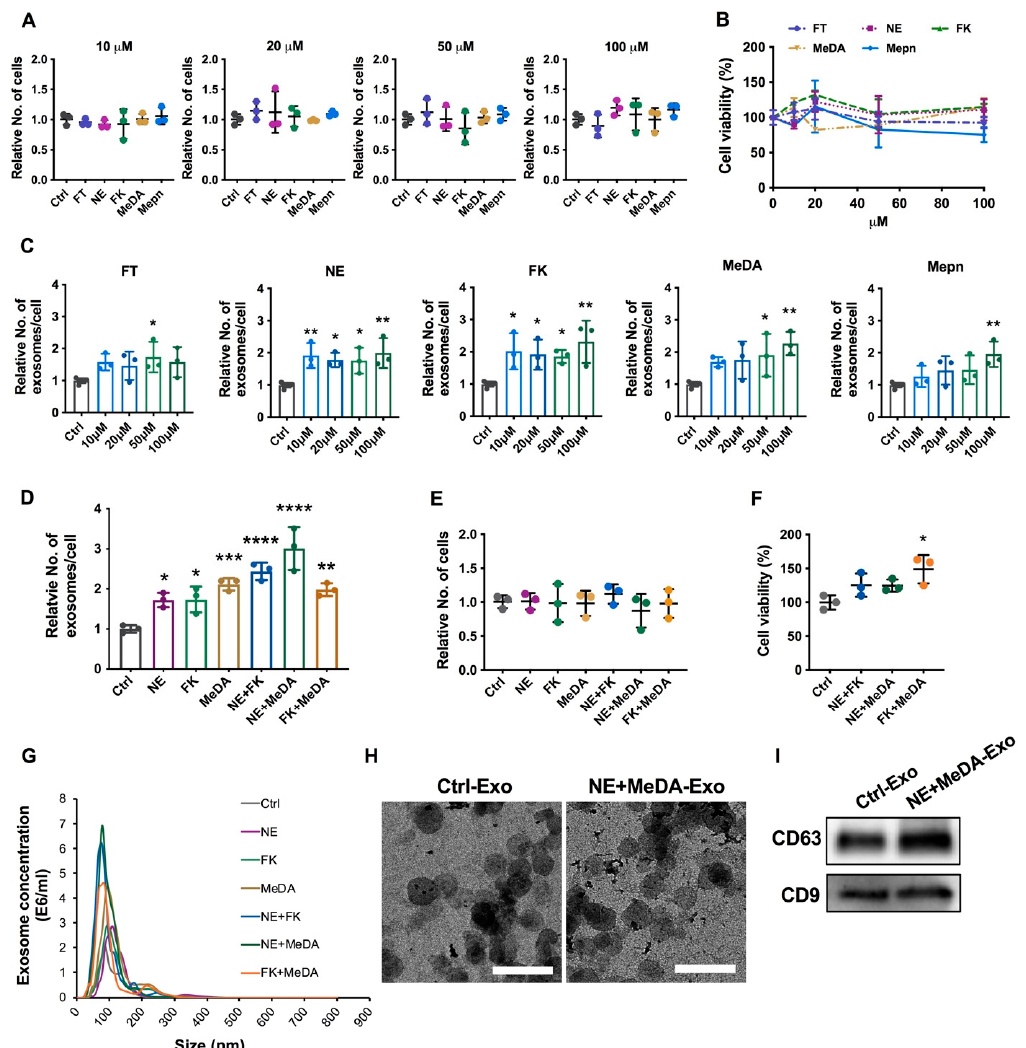
Figure 1. Effects of small molecules on MSC cell viability and exosome production efficiency. ( A ) Cell proliferation rate. ( B ) The cell viability and metabolism of mesenchymal stem cells (MSCs) treated with di ff erent doses of compounds measured by the 3-(4,5-dimethylthiazol-2-yl)-2,5-diphenyl tetrazolium bromide (MTT) assay. ( C ) The production e ffi ciency of exosomes derived from MSCs treated with di ff erent doses of compounds. ( D ) The production e ffi ciency of exosomes derived from di ff erent MSCs treated with combinations of compounds. ( E ) The cell proliferation rate of MSCs in response to treatment with small molecule modulators. ( F ) The cell viability and metabolism of MSCs after treatment with small molecule modulators measured by the MTT assay. ( G ) The size distribution of exosomes by nanoparticle tracking analysis (NTA) in response to the treatment of MSCs with small molecule modulators. ( H ) Transmission electron microscopy (TEM) images of exosomes, scale = 200 nm, Exo: Exosomes. ( I ) CD63 and CD9 exosomal surface marker protein expression by Western Blotting. One-way ANOVA with Dunnett’s multiple comparisons test; * p < 0.05, ** p < 0.01, *** p < 0.001, **** p < 0.0001, n = 3–6 each group. FT: fenoterol; NE: norepinephrine; FK: